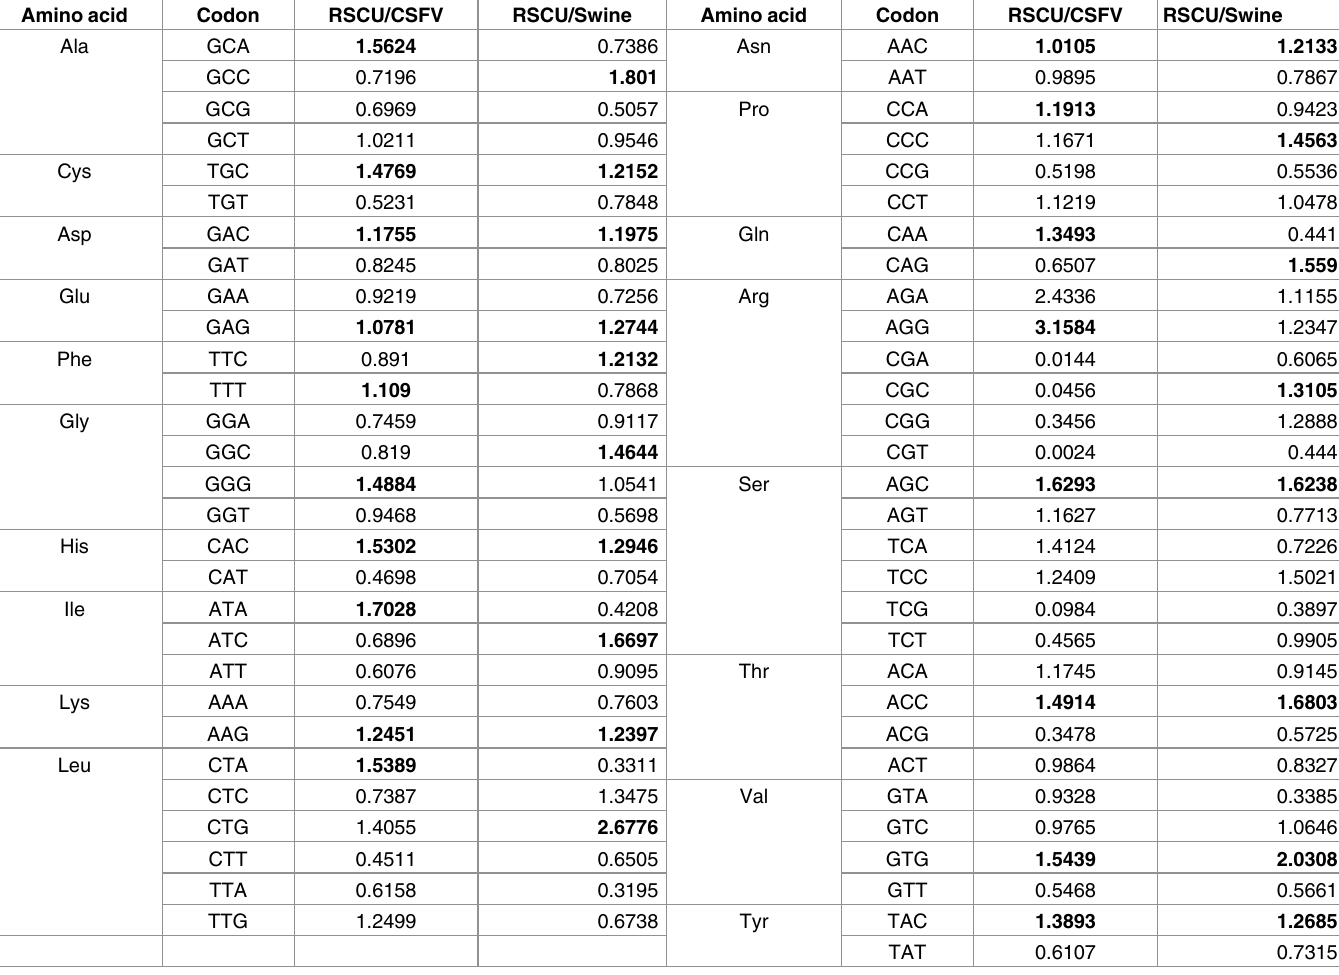
Table 1. Overall RSCU of the 140 collected sequences of the E2 gene of the